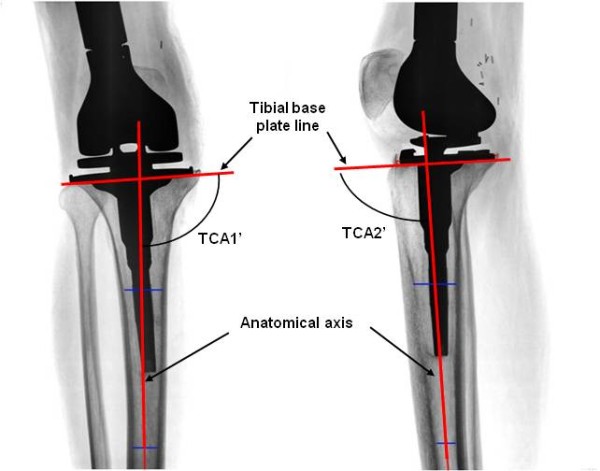
Measurement of tibial componentangle in coronal viewand sagittal view onX-ray.